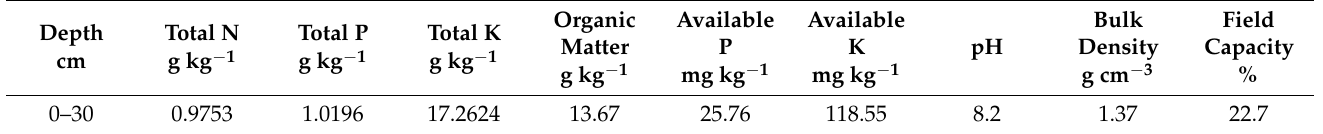
Table 1. Physical and chemical properties of soil profiles in the experimental